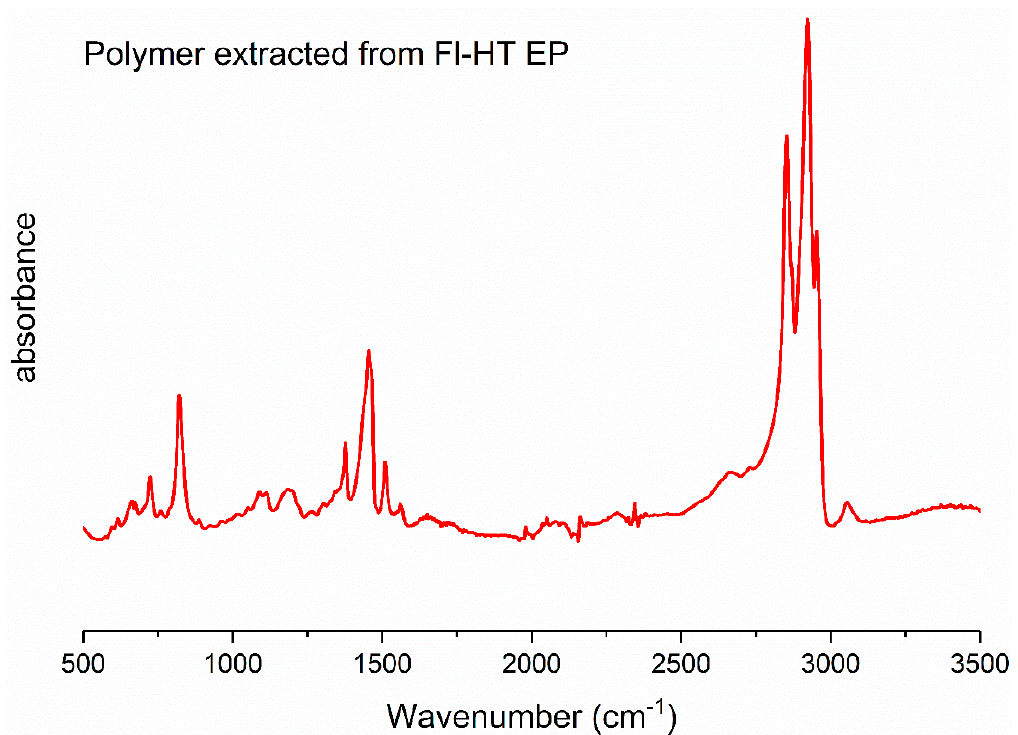
Figure A2. IR spectrum of the polymer fraction of Fl-HT EP soluble in chloroform and deposited from solution on the IR spectrometer ATR crystal.